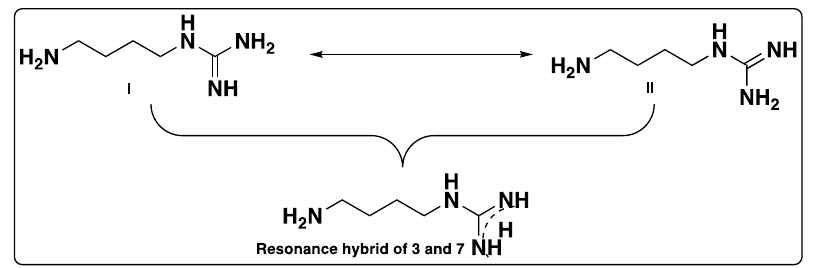
Figure 2. Resonance forms of 3 or 7 .